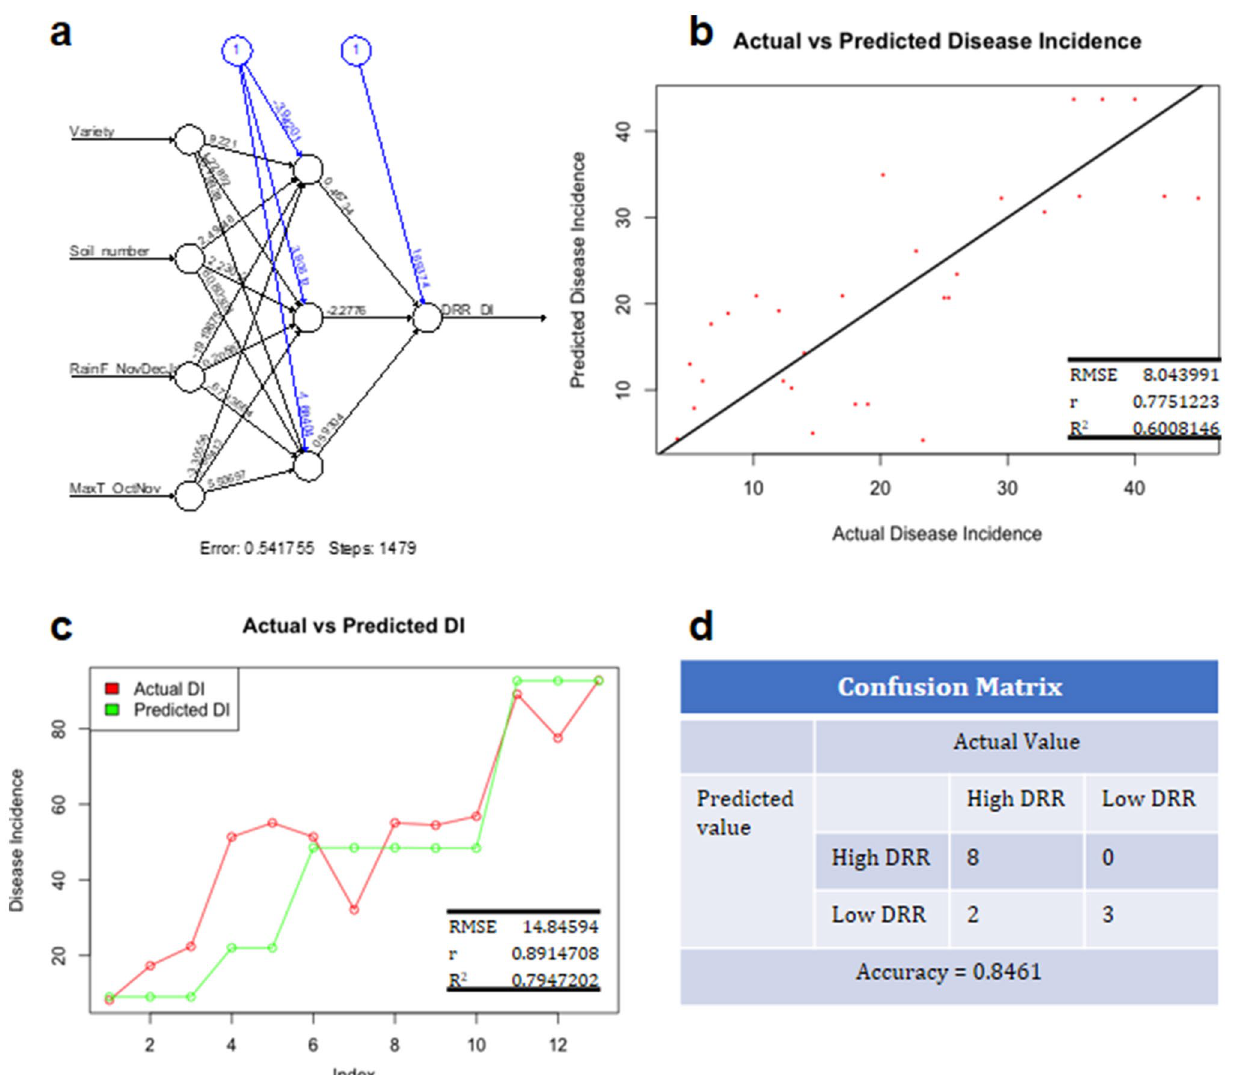
Figure 2. Training, testing, and validation of neural network. Neural network was trained using total rainfall from November to January (RainF_NovDecJan), an average of maximum temperature for the October and November months (MaxT_JanFeb) along with information about variety (Variety) and soil type (Soil_number) as input, and DRR disease incidence data (Supplementary File S1) as output. The entire dataset was divided into 70% training set and 30% testing set. Neural network (NN) was trained in R using neuralnet algorithm with backpropagation method. The best fit in NN training was obtained with one hidden layer having three nodes. Network topology for the training and linear regression between actual and predicted for the training set are shown in ( a ) and ( b ), respectively. Numbers in connecting lines from input layer to hidden layer and from hidden layer to output layer represent weights used in the model and number connecting blue circles are biases. Linear activation function was used for the network training. Validation of the trained neural network was performed with DRR disease incidence from the current (2019–2020) field experiment study and with DRR incidence data of location-2 from Sinha et al. (2019) research article. Validation data set included DRR disease incidence data from severe combined stress treatment plots. Input and output data used for validation is in Supplementary File S1. A comparison between actual (red) and predicted DRR disease incidence (green) is shown as line graph ( d ). RMSE, r and R 2 is showing root mean square error, correlation coefficient and coefficient of determination, respectively. DRR incidence was categorized into High DRR (disease incidence > 30%) and Low DRR (disease incidence < 30%) and confusion matrix was created with actual and predicted DRR incidence for the validation set. The prediction accuracy was